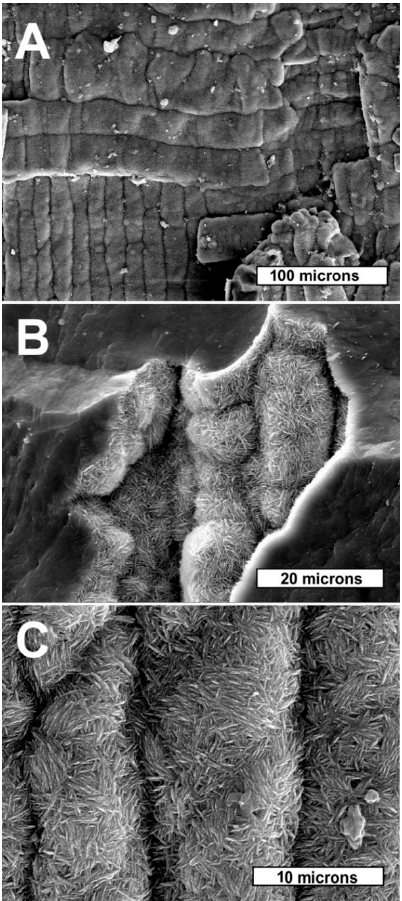
Figure 8. Petrographic thin sections of the transverse plane. ( A ) Vessels surrounded by cellular tissue in plain light illumination and ( B ) in cross-polarized light illumination.